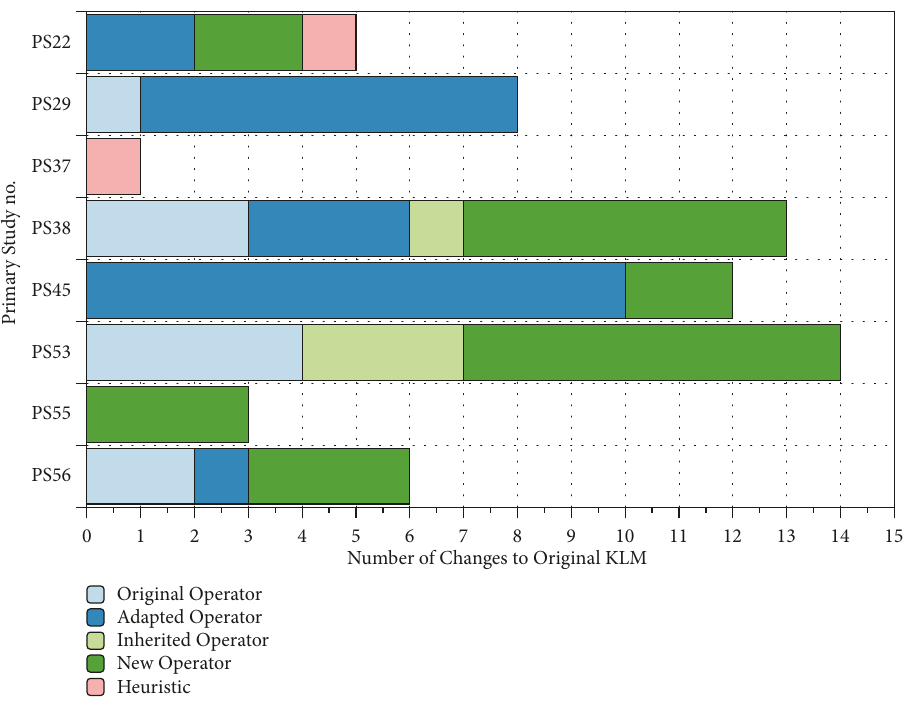
Figure 10: The number of original operators preserved, adapted, inherited from other extensions or prior literature, and newly introduced in the touch-based mobile or tablet